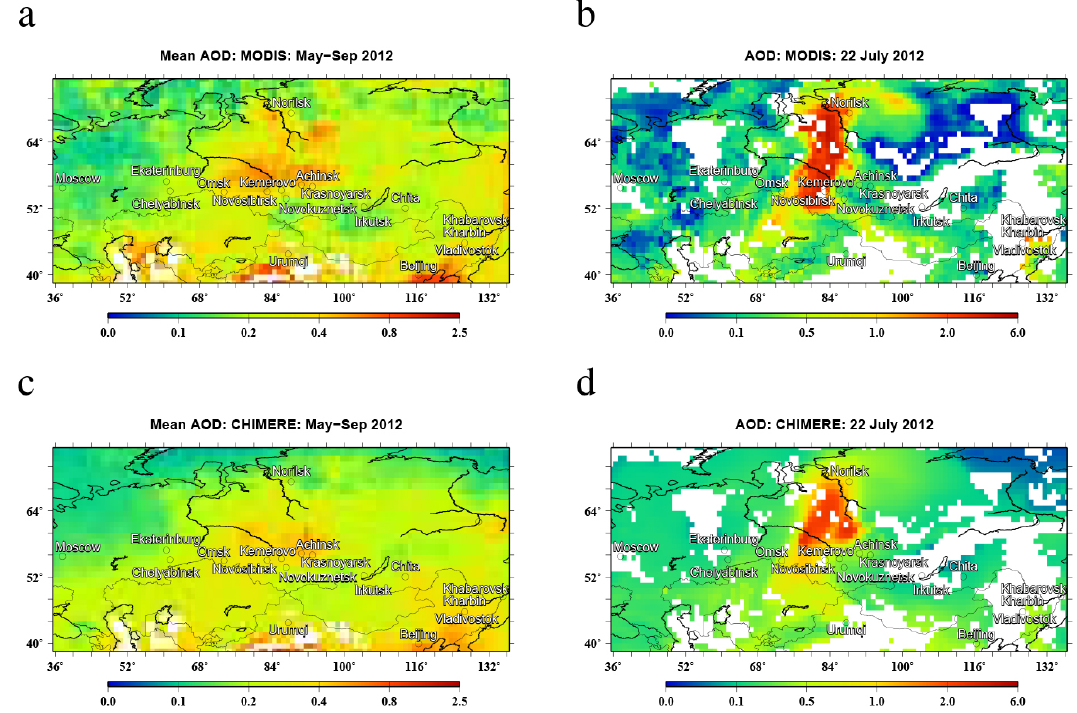
Figure 6. Same as in Fig. 5 but for AOD